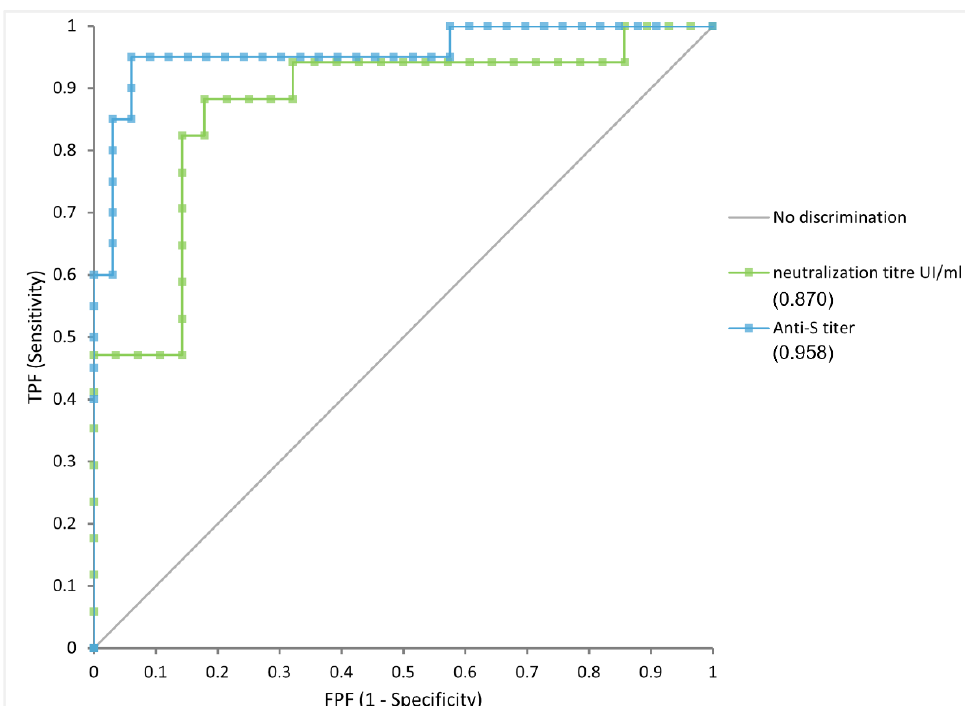
Figure 3. Receiver operating characteristic curve (ROC) for prediction of neutralization titers ≥1:16 by cVNT based on the anti-S eCLIA and sVNT, AUC (area under the curve); anti-S eCLIA: 0.958 (95% CI 0.889 – 1.011); sVNT: 0.870 (95% CI 0.752 –0.988) ( p < 0.0001).